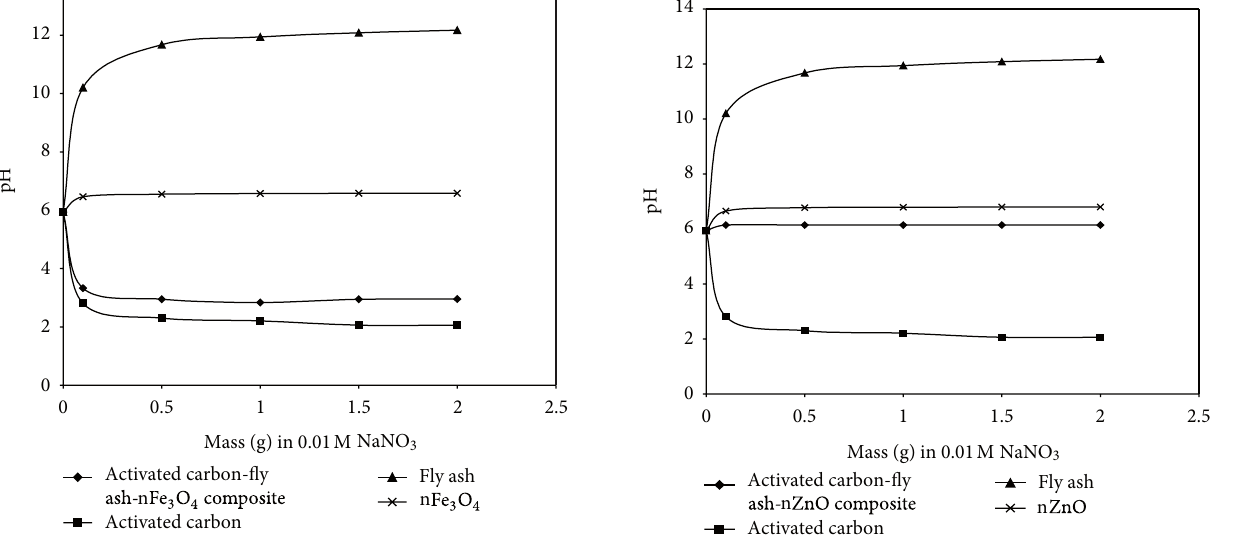
F 19: Result of mass titration experiments with activated car- bon, �y ash, n�nO, and activated carbon-�y ash-n�nO composite material. Variation of pH versus mass of solid in 0.01M